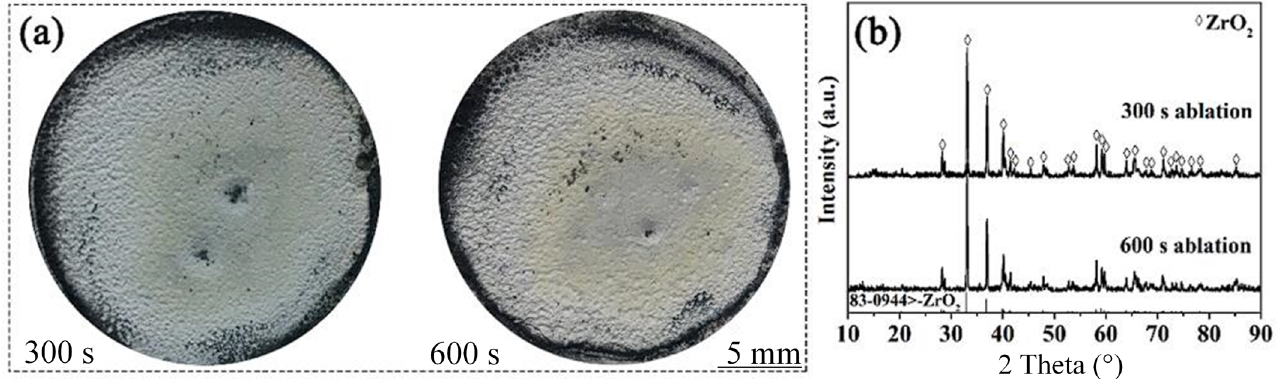
Figure 5. Ablative properties of ZrC–SiC coatings. ( a ) Appearance and ( b ) XRD properties of coatings ablated at various times. Reprinted/adapted with permission from Ref. [121]. Copyright 2022, Elsevier.